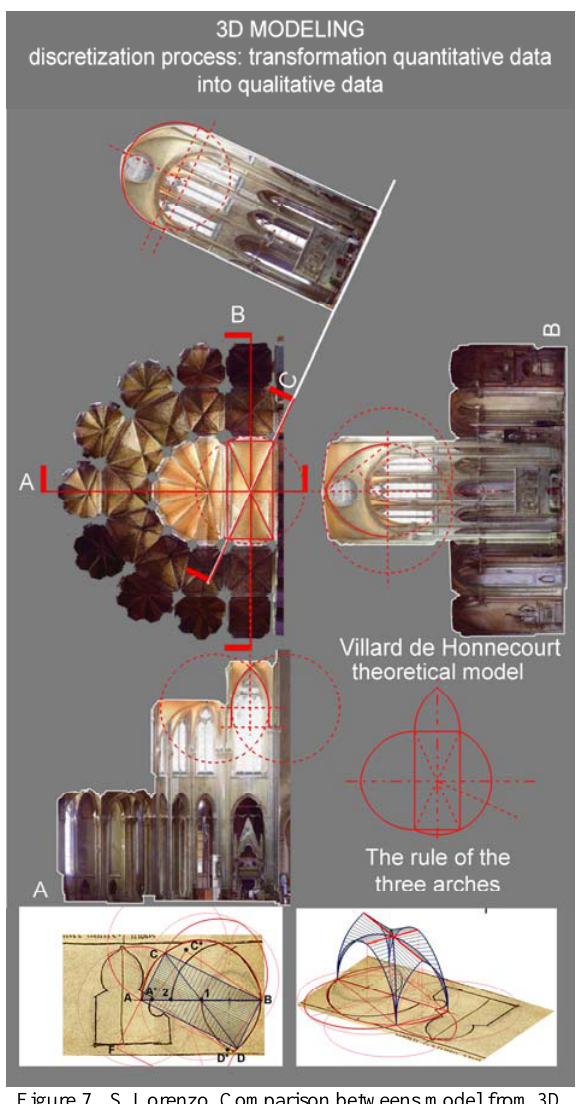
Figure 7. S. Lorenzo. Comparison betweens model from 3D laser scanner point cloud and theoretical model.